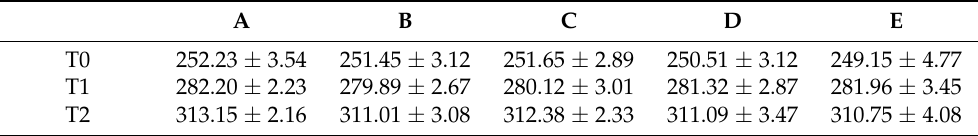
Table 1. Mean and standard deviation ( ± SD) of fish total body weight (g) at 0 (T0), 15 (T1), and 30 days in the five treatment groups (A: control; B: 0.5%; C: 1%; D: 2%; E: 3% w / w F1-BEO). N = 40 rainbow trout ( Oncorhynchus mykiss ) for each treatment.